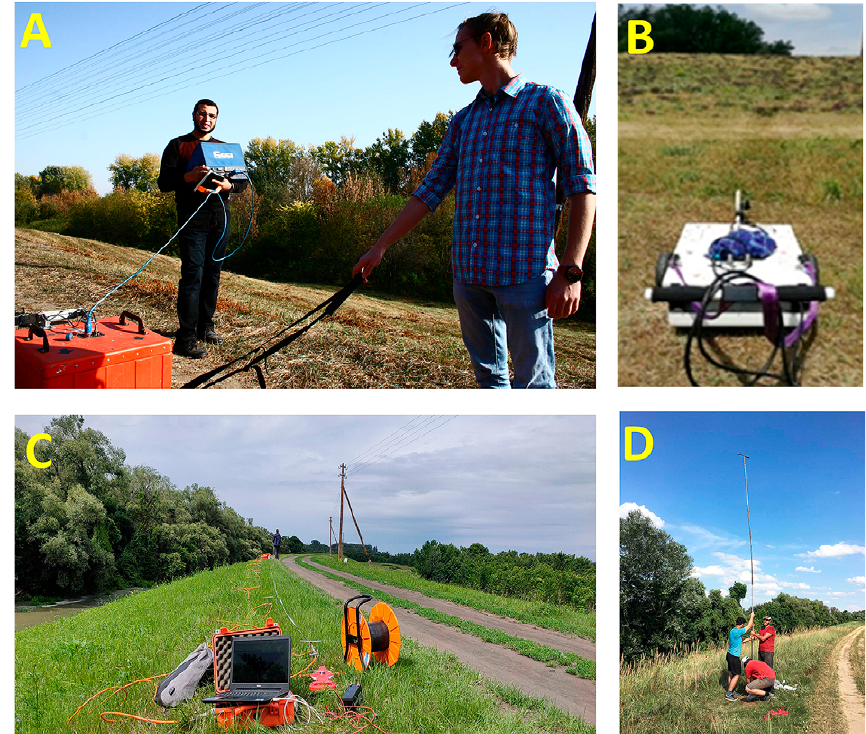
Figure 2. Data acquisition by A) GSSI SIR3000 GPR system with a 200 MHz antenna, B) IDS GPR system with an 80 MHz antenna, C) GEOTOM MK8E100 multi-electrode ERT system and D) drilling using an Eijkelkamp-type drilling